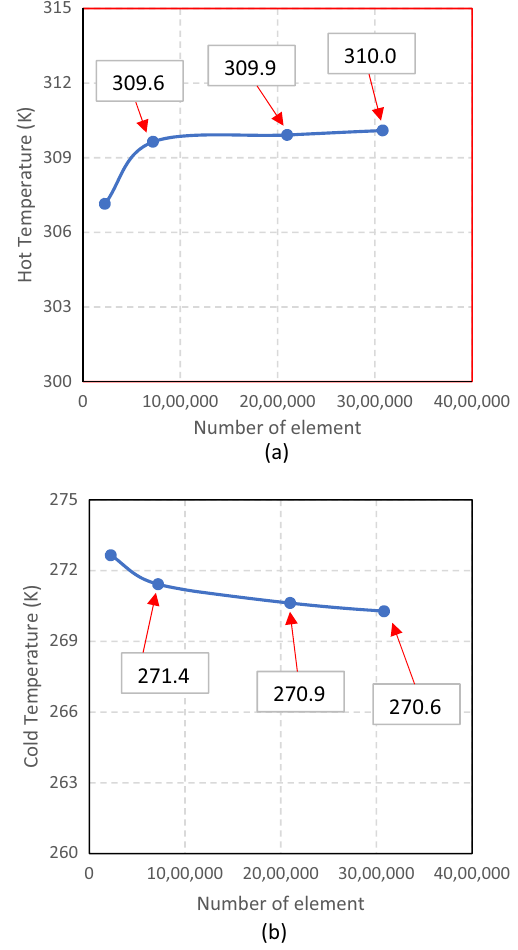
Fig. 3 Effect of number of elements on a the hot and b the cold outlet temperatures